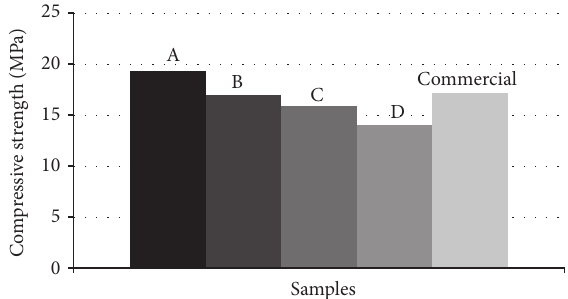
Figure 4: Compressive strength of standard lightweight cube con- crete and LC with different ratio of WLA to cement (wt/wt) (A) 55%, (B) 60%, (C) 65%, and (D) 70%.